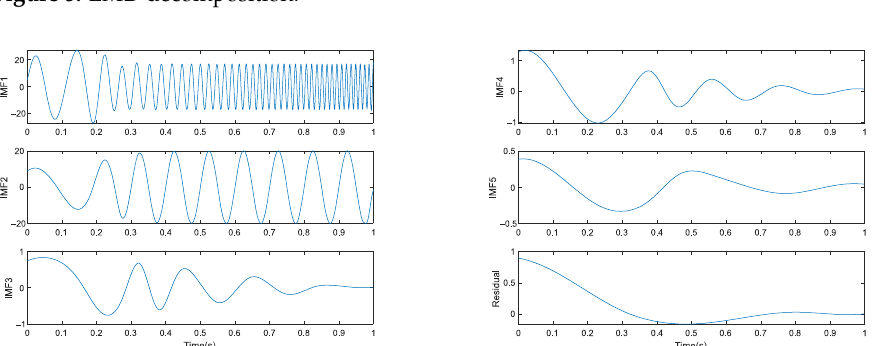
Figure 5. EMD decomposition.